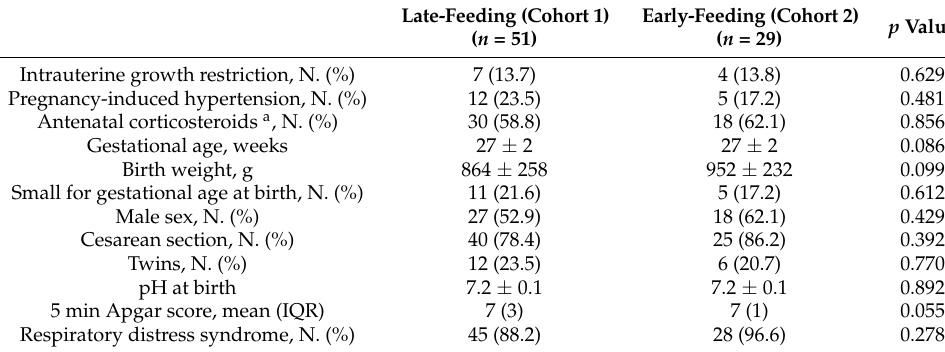
Table 1. Baseline characteristics of the study